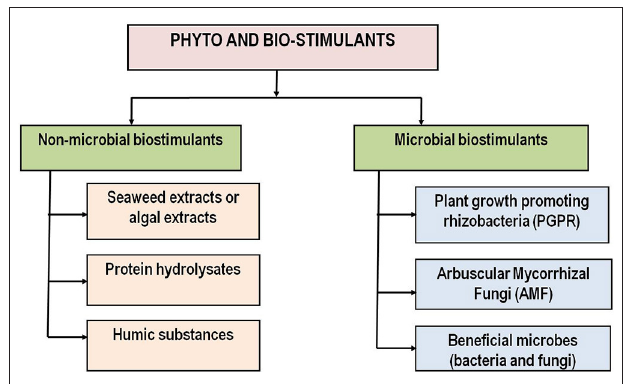
FIGURE 1 | Graphical presentation of different types of microbial and non-microbial